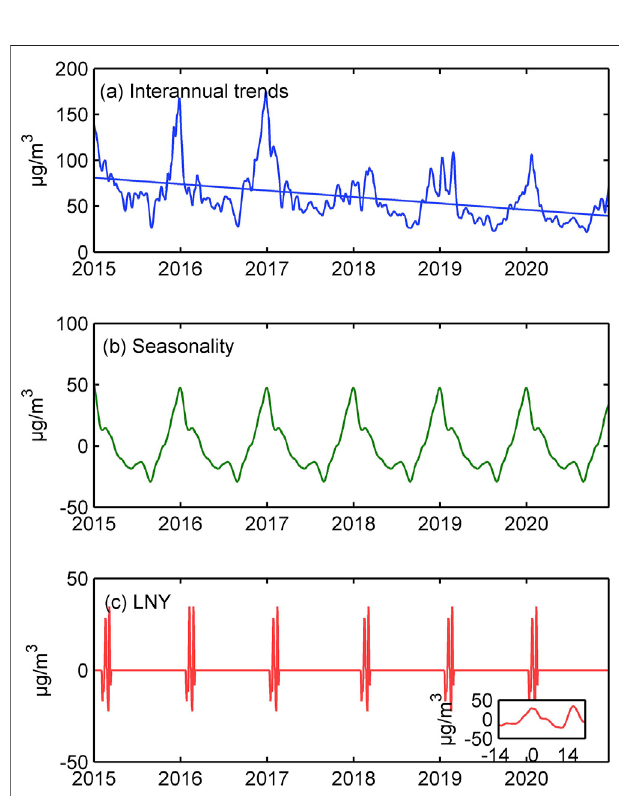
FIGURE 5 | Time series of (A) inter-annual trends, (B) seasonal signals and (C) LNY for PM 2.5 (µg/m 3 ).A 30-days smoothing window is applied to (A) and (B) , and a 7-days smoothing window is applied to (C) . The graph in (C) is the PM 2.5 concentration two weeks before and three weeks after the Lunar New